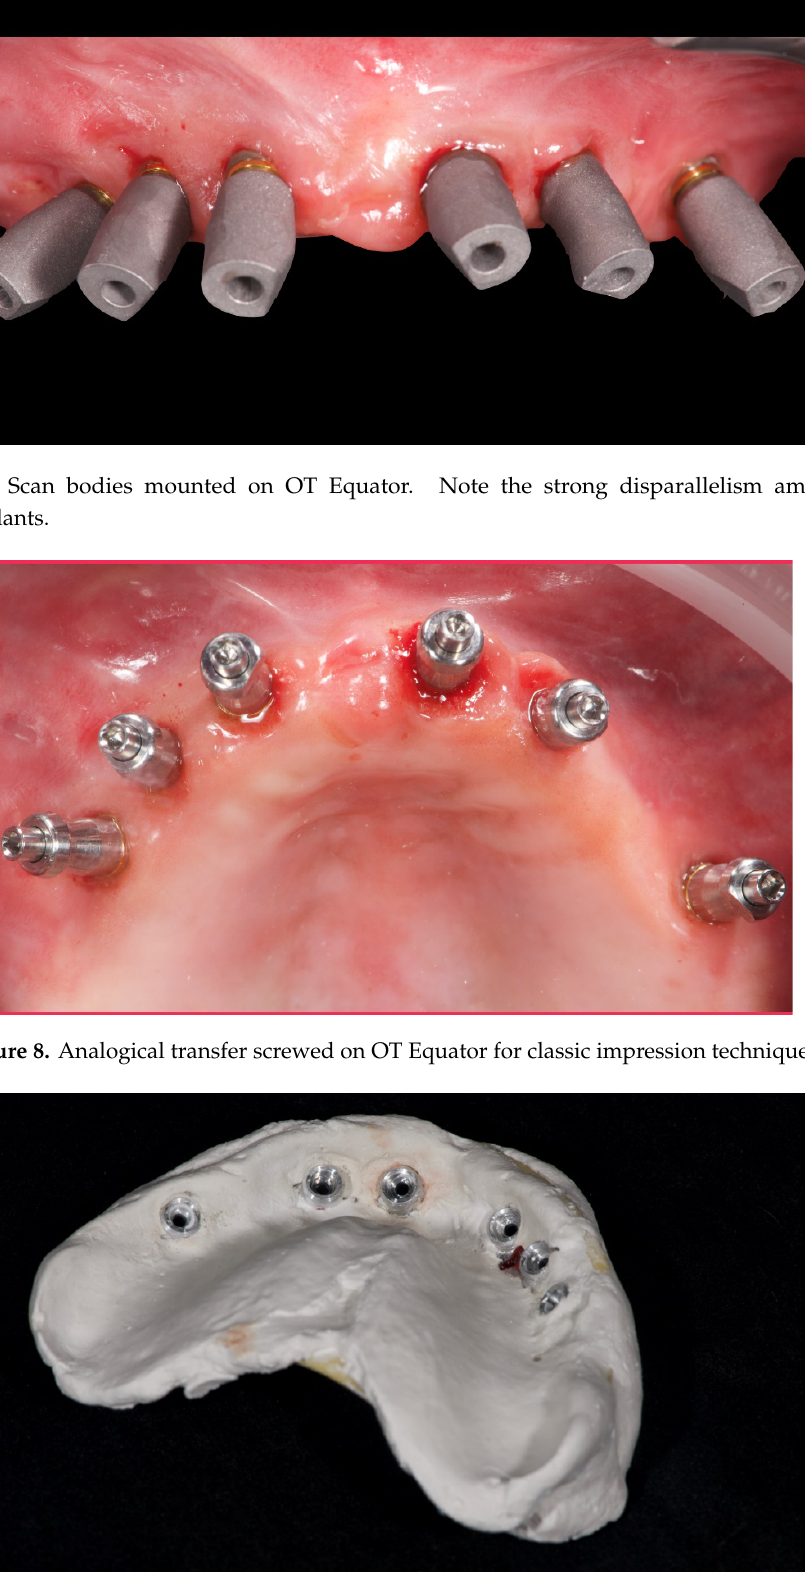
Figure 9. Internal detail of the plaster impression.